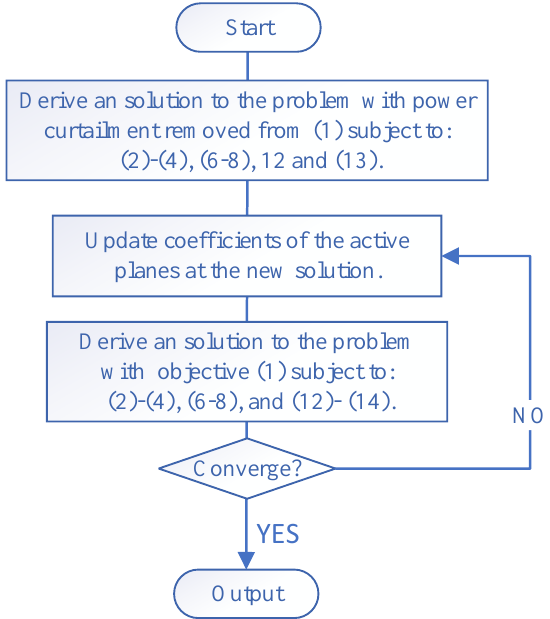
Figure 3. Procedure to update the active planes.